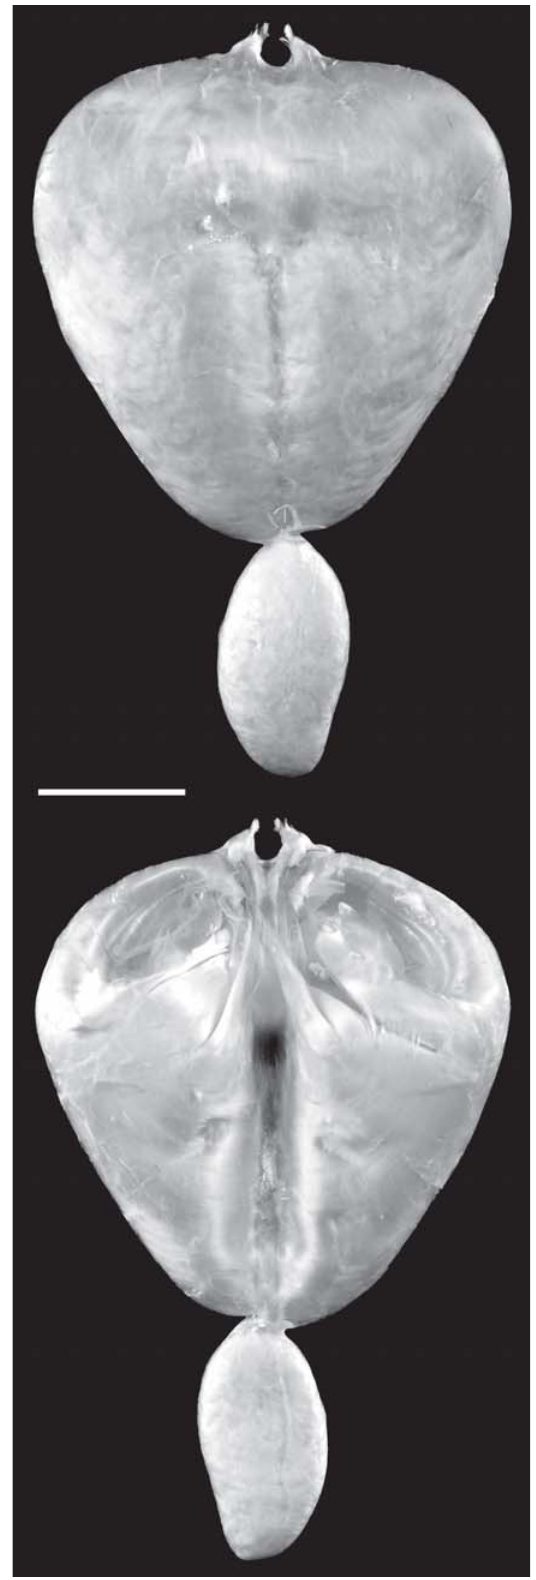
Fig. 4. Ventral (top) and dorsal (bottom) views of gas bladder in Platydoras brachylecis , ANSP 187051, 179 mm SL. Scale bar = 1 cm. Photos by M. Sabaj